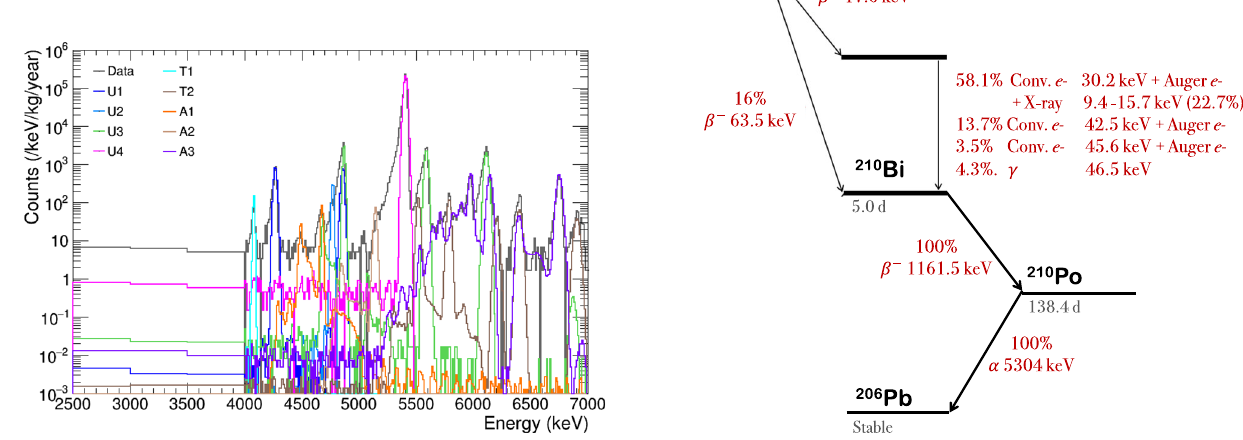
Fig. 5 Energy spectra of α events in C2. The black solid line repre- sents the measured α energy distribution and other colors represents the simulation results for internal